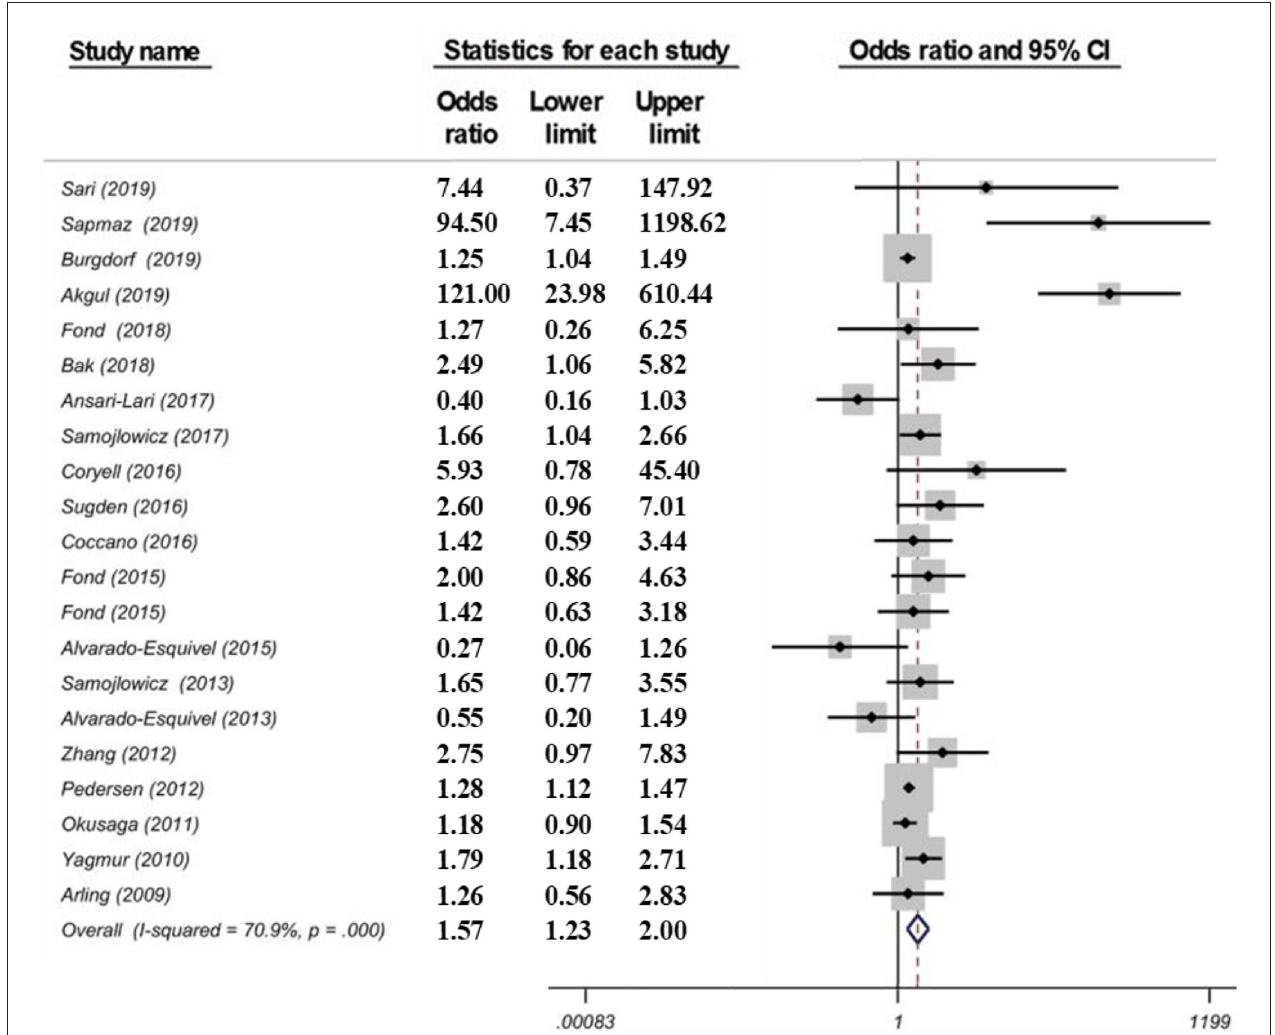
FIGURE 4 | Forest plot showing a correlation between T. gondii infection (IgG) and suicide attempts as reported in a meta-analysis from 21 data sets by Amouei et al. ( 105). Serointensity associations with suicide attempts, even when significant, such as Arling et al., Okusaga et al., and Zhang et al. are not presented and studies thus appear as carrying no significant association with T. gondii serolog y [Modified and reprinted with permission from (105); Copyright (2020); with permission from John Wiley & Sons; License #